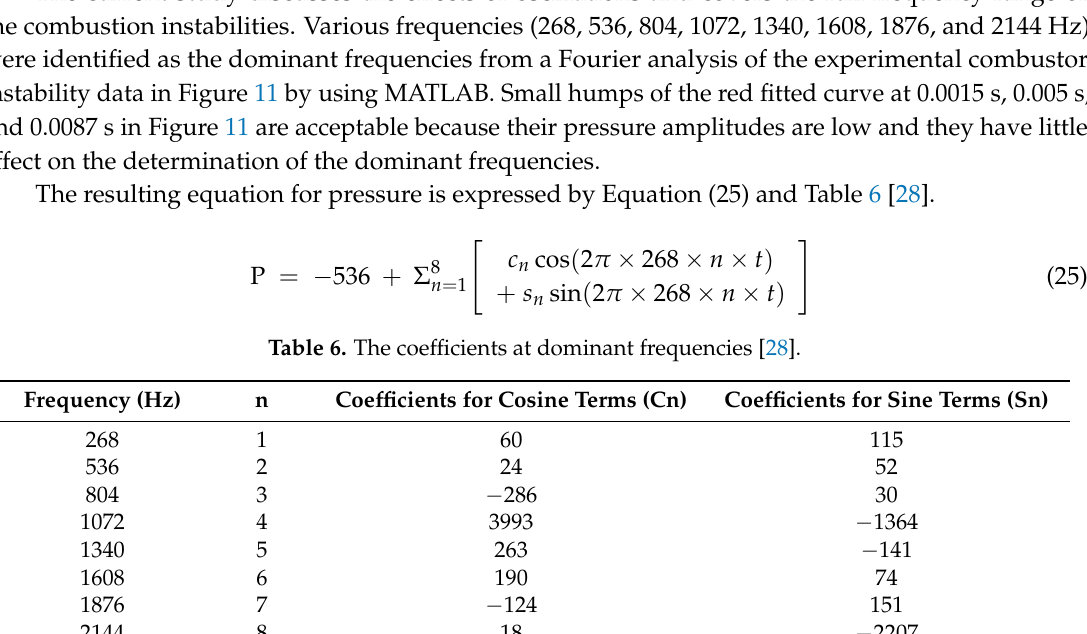
Table 6. The coefficients at dominant frequencies [28].